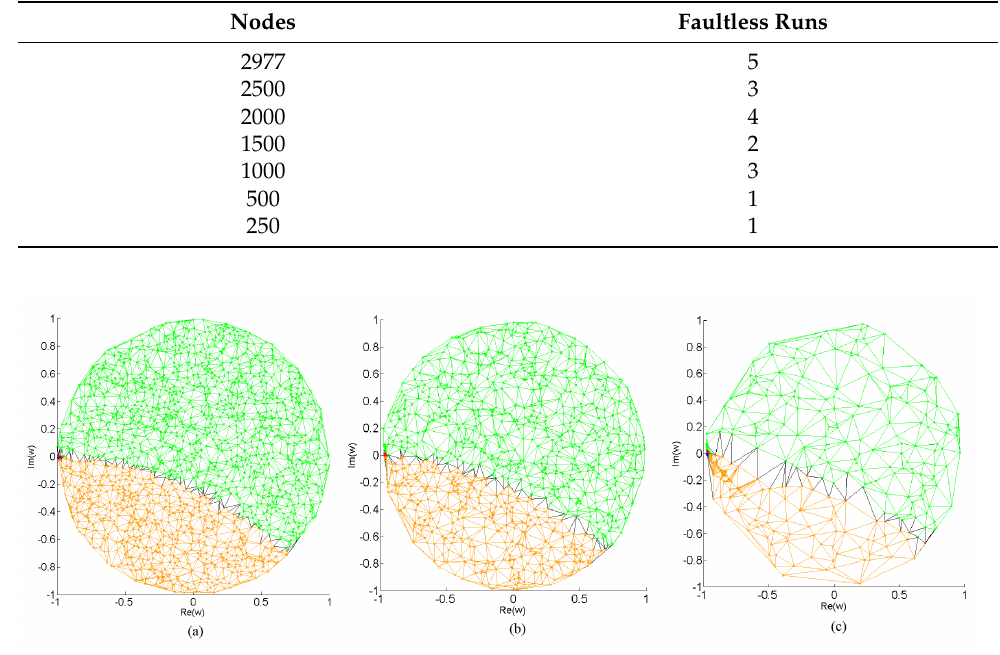
Table 4. Initial number of individuals (nodes) and number of runs with correctly detected zeros for the MGA-WPA method. The stability test is executed 5 times for each number of nodes. A faultless run means that the filter instability is detected (zero is found inside the w -plane unit circle).